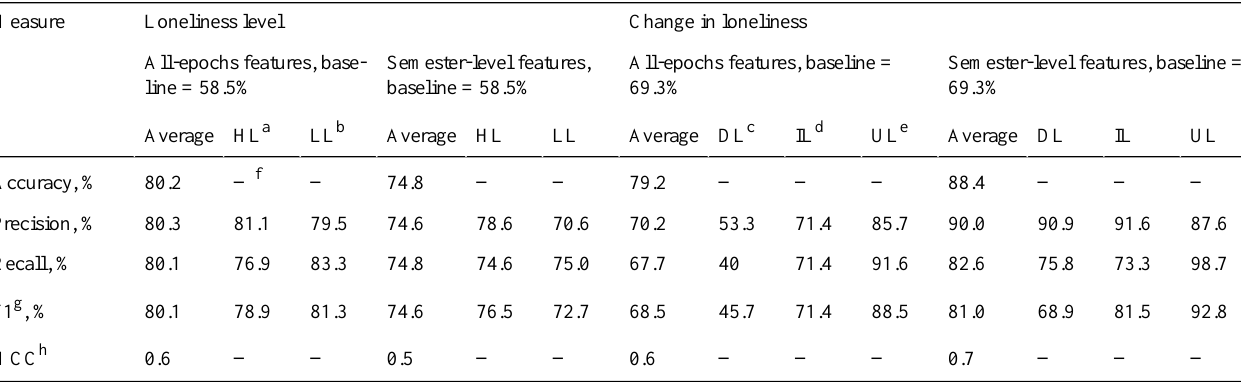
Table 5. The performance of models obtained from all-epochs features and semester-level features to detect loneliness level and change in loneliness.